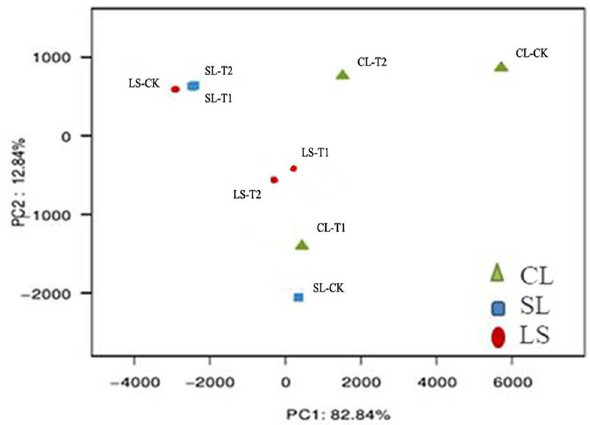
Figure 3. PCA analysis of different treatments.